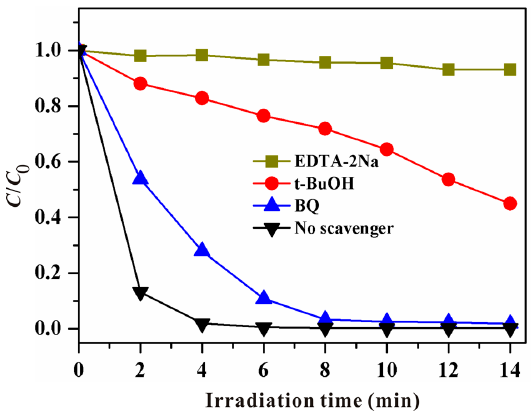
Figure 12. The photocatalytic activity of Ag 3 PO 4 -200 for the degradation of MB under visible light upon the addition of different scavengers.